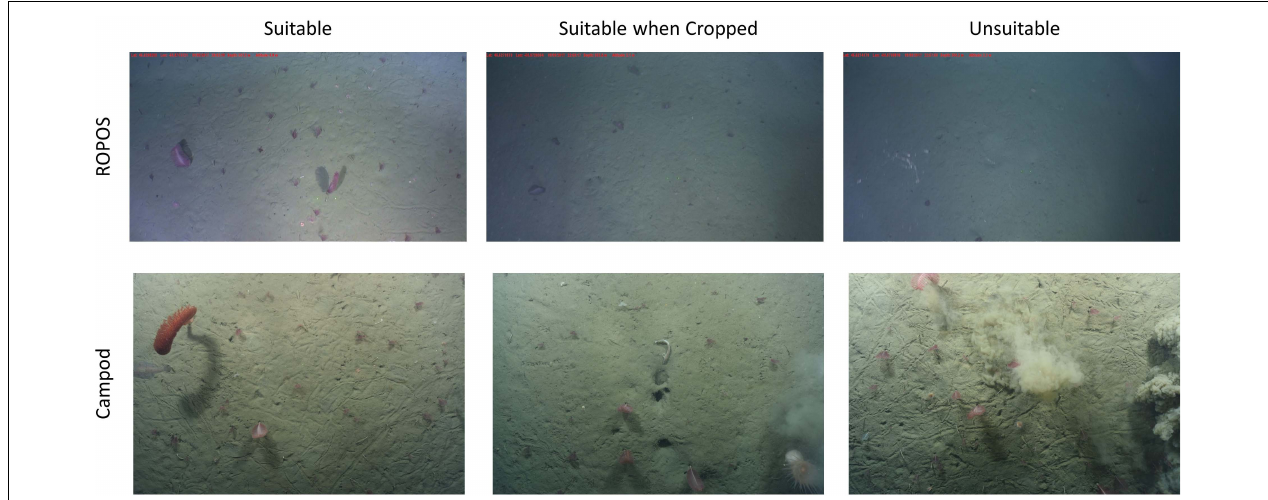
FIGURE 3 | Examples of imagery collected by the ROV ROPOS (first row) and the drop camera Campod (second row), deemed suitable (left) or unsuitable (right) for analysis (e.g., poor illumination, blurry edges, sediment plumes). If less than 50% of an image was unsuitable and the scaling lasers were visible (middle), then those images were cropped before enumerating fauna and calculating the area